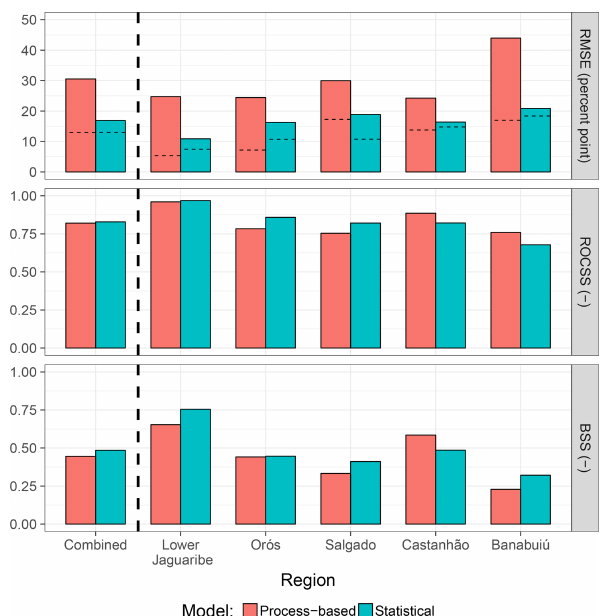
Figure 4. Model performance in hindcast mode for the two model approaches. In the top panel, horizontal dashed lines in the bars mark the results obtained with observed forcing (simulation mode, as in Fig. 3). Note that for RMSE low values indicate a better per- formance while for ROCSS and BSS higher values are favoured.